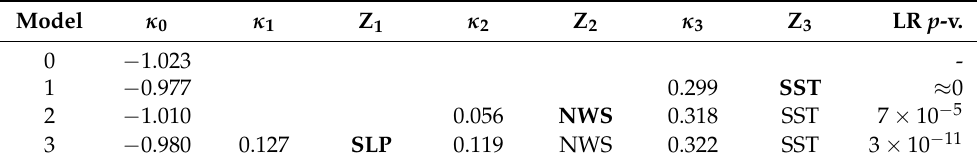
Table 3. Hyperparameter estimates and corresponding covariates for the best model at each step of the mixed selection for the dynamic Joe copula between S and H S